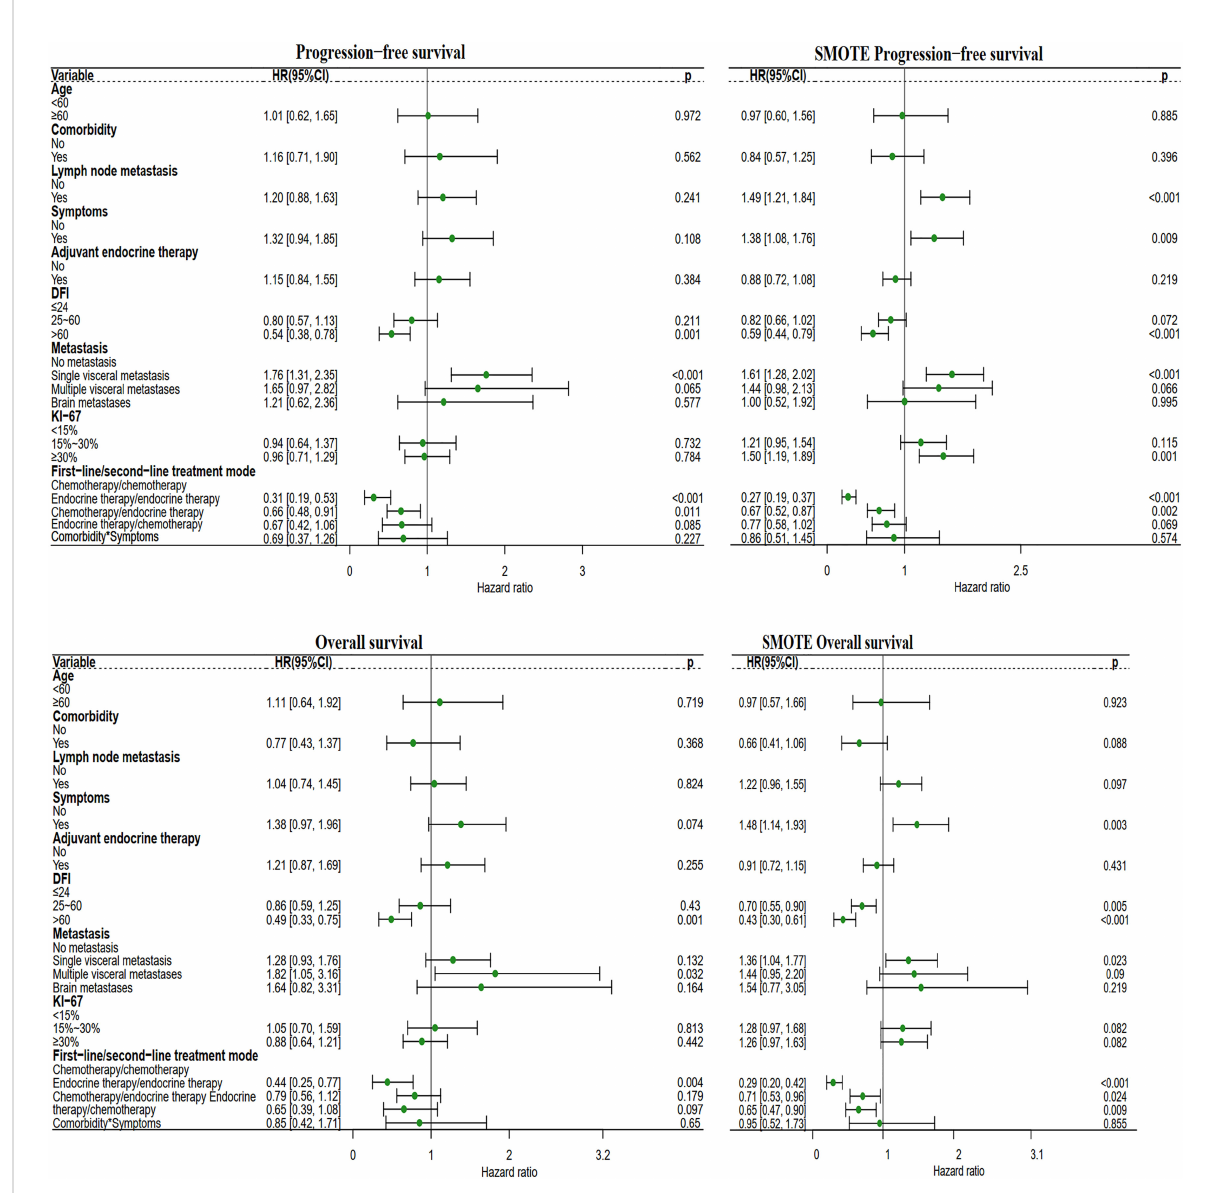
FIGURE 7 Forest plot of the four different fi rst-line/second-line treatment modes. The fi rst-line/second-line treatment mode, includes the chemotherapy/ chemotherapy mode, endocrine therapy/endocrine therapy mode, chemotherapy/endocrine therapy mode, and endocrine therapy/ chemotherapy mode. In this analysis, the other three modes were compared with the chemotherapy/chemotherapy